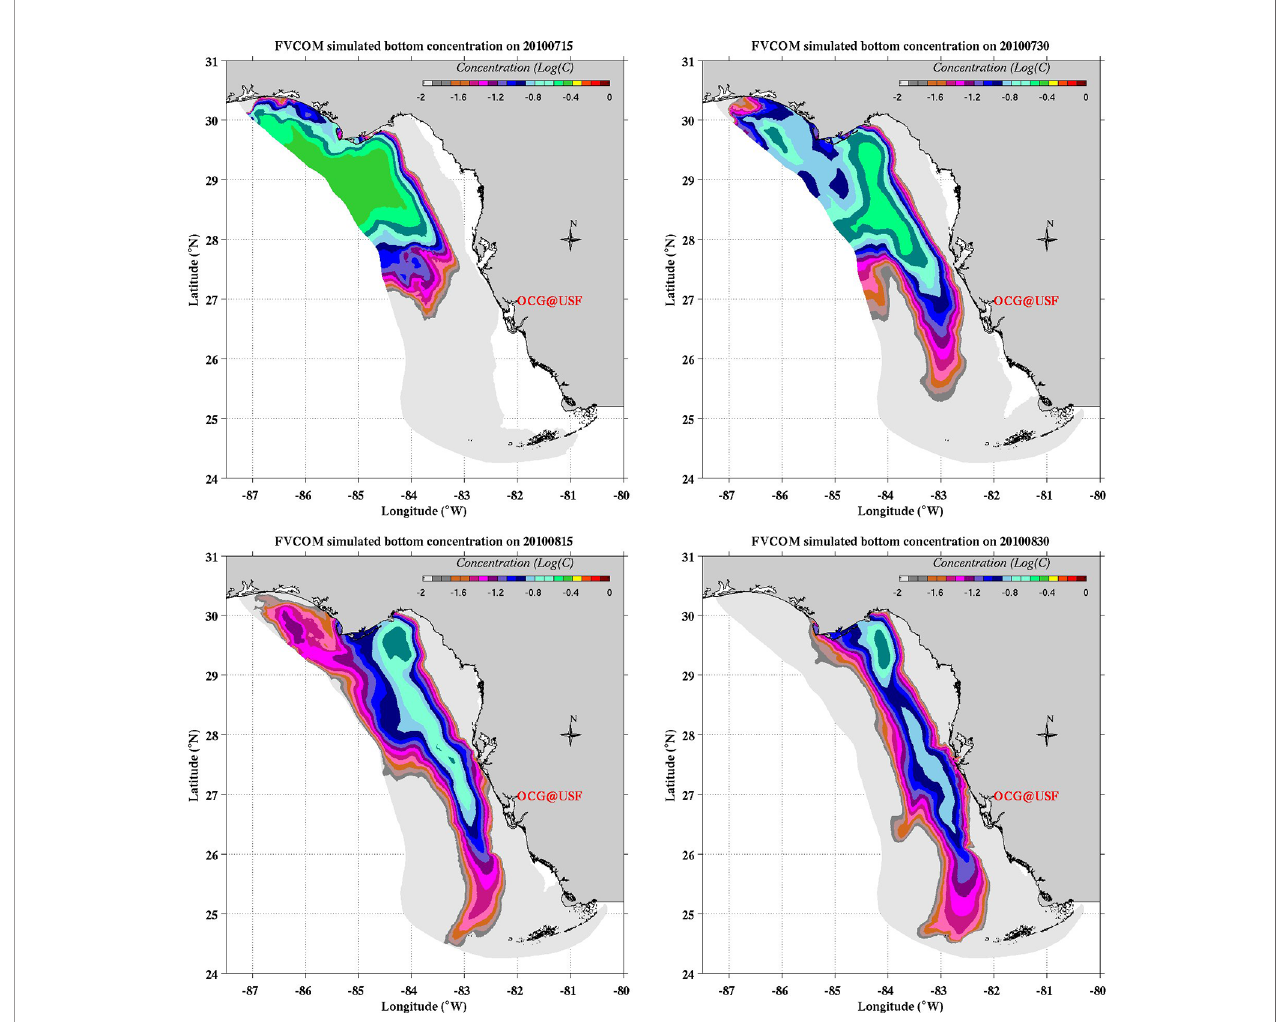
FIGURE 12 | WFCOM-simulated normalized near-bottom tracer concentration sampled on July 15, 2010; July 30, 2010; August 15, 2010; and August 30, 2010. With the initial value being 1.0, and the tracer concentration color bar provided on a log 10 scale, the green region on the upper two panels corresponds to 0.40, and the dark blue and mid-range magenta regions on all panels correspond to 0.12 and 0.05, respectively. The gray region represents the lowest tracer concentration value plotted, and its location on the left-hand side demarks the offshore extent of the WFCOM domain used in this simulation (adapted from Weisberg et al.,